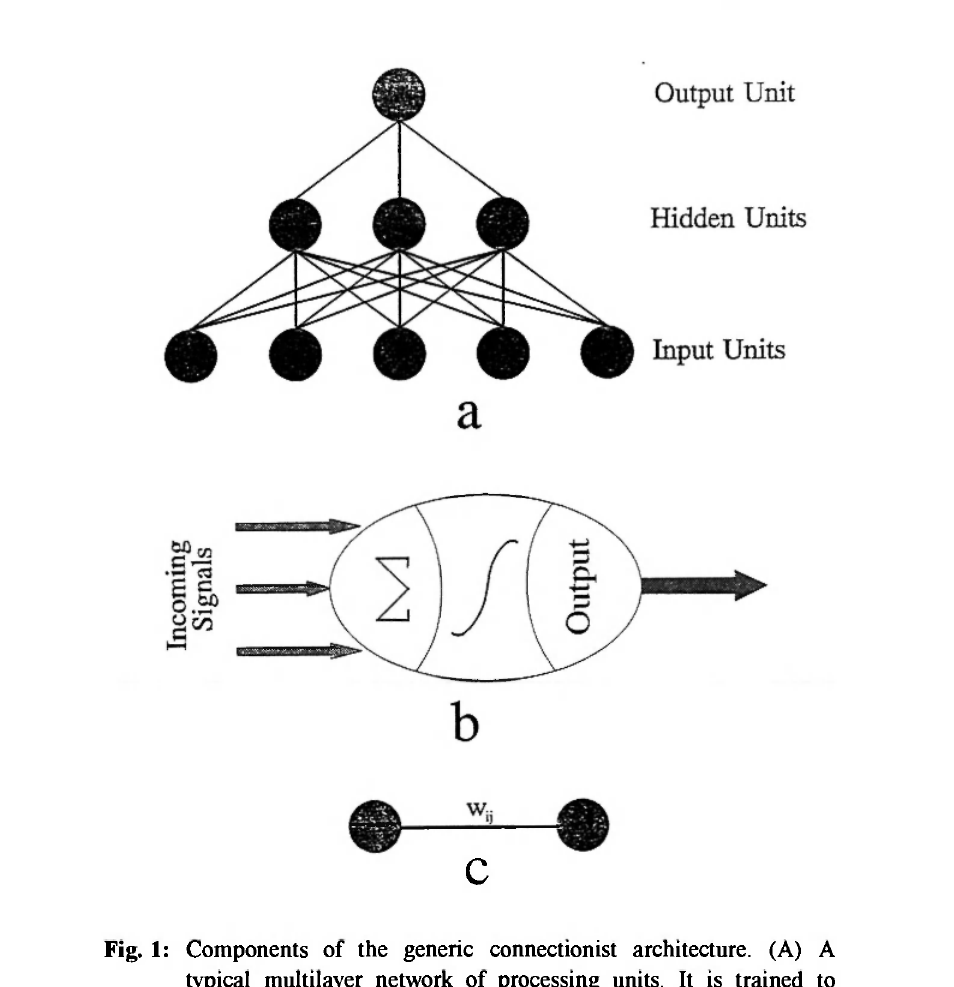
Fig. 1: Components of the generic connectionist architecture. (A) A typical multilayer network of processing units. It is trained to generate a particular response to patterns that are presented to the input units. Hidden units can be viewed as feature detectors. (B) The three basic operations of a single processing unit. See the text for details. (C) Processing units communicate through a connection that has the numerical weight w-; learning rules are used to modify weight